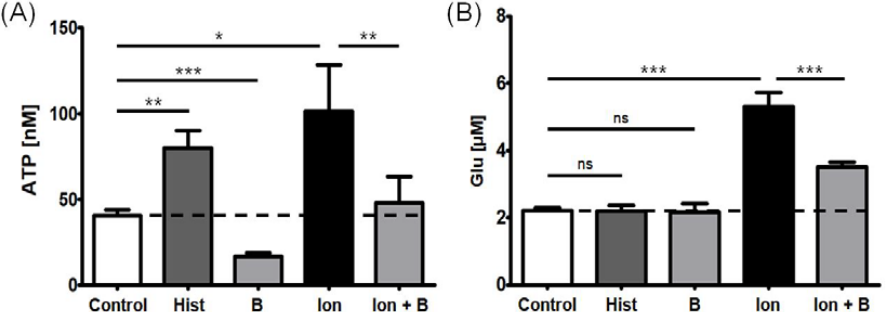
Figure 2. Effect of 10-min treatment with positive controls (histamine 100 µ M and ionomycin 5 µ M) and a negative control (BAPTA-AM 50 µ M 30-min pre-treatment) on ( A ) ATP and ( B ) Glu release from the astrocyte cultures. The effect of BAPTA-AM was tested in the presence and absence of ionomycin. The bars represent the mean estimates, whereas the whiskers indicate standard errors of means. Dashed lines indicate the level of ATP and Glu released in control conditions (fresh experimental medium or HEPES buffered Ca 2+ -containing solution, respectively). The number of biological replicates n ≥ 9 for each condition. One-way analysis of variance with post hoc Dunnett’s test, significance level α = 0.05. * p < 0.05, ** p < 0.01, *** p < 0.001. ns—not significant, Hist—histamine,